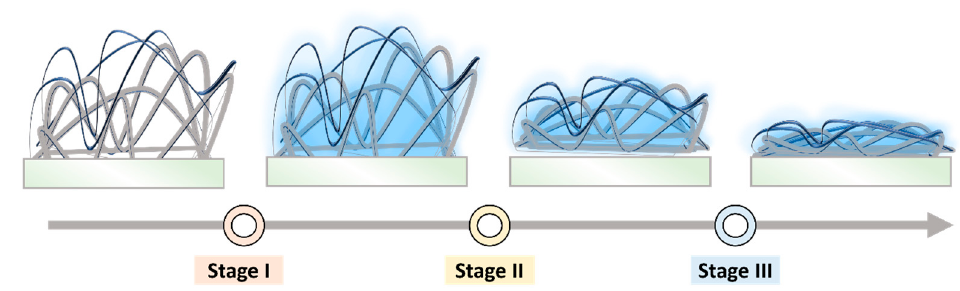
Figure 7. Schematic diagram of the VOC sensing behavior.